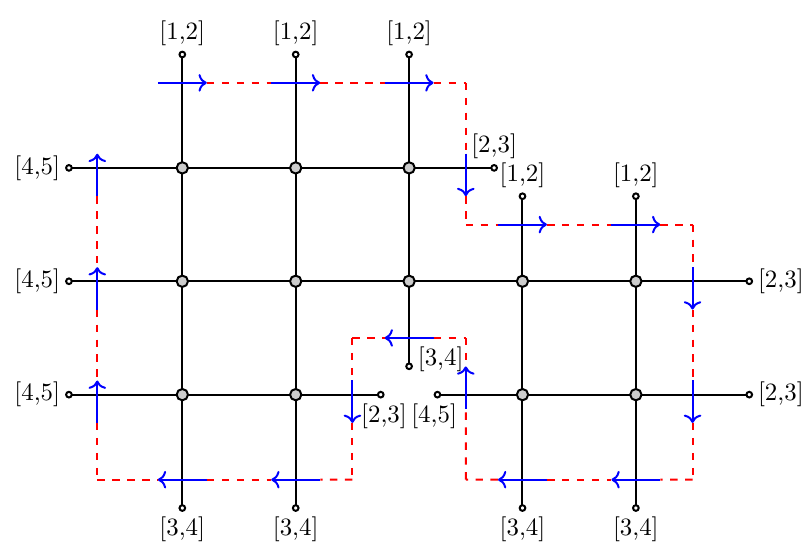
Figure 6 . We act with the monodromy, i.e. with the ordered matrix product of conformal Lax operators on the left hand side of eq. (4.2), on the (cid:12)shnet graph from (cid:12)gure 2. The monodromy is depicted by the oriented contour. Lax operators correspond to solid blue segments of the contour and dashed red lines denote summation over matrix indices. The contour is decorated by inhomo- geneities [ (cid:14) + ; (cid:14) (cid:0) ] of the monodromy, which indicate the shifts in the arguments of Lax operators i i L ( u + (cid:14) + ; u + (cid:14) (cid:0) ), cf. eq. i i